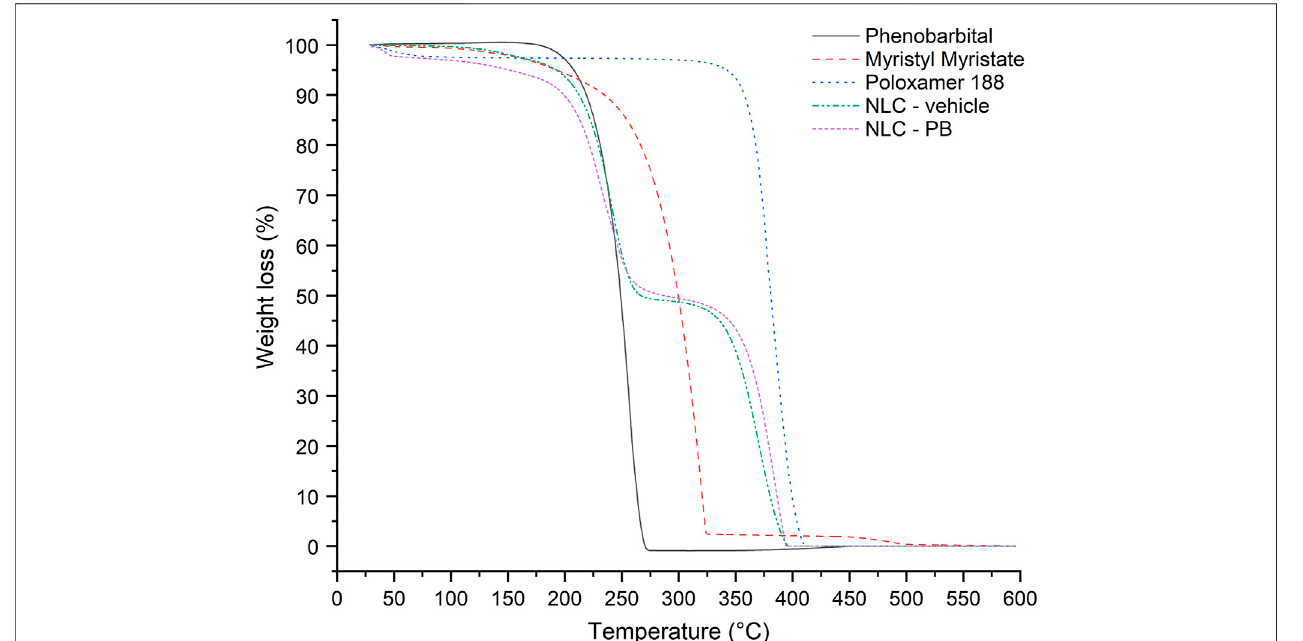
FIGURE 5 | TGA thermograms of PB, myristyl myristate, Poloxamer 188, NLC-vehicle, and NLC-PB were obtained in the range of 30 ° C – 600 ° C.